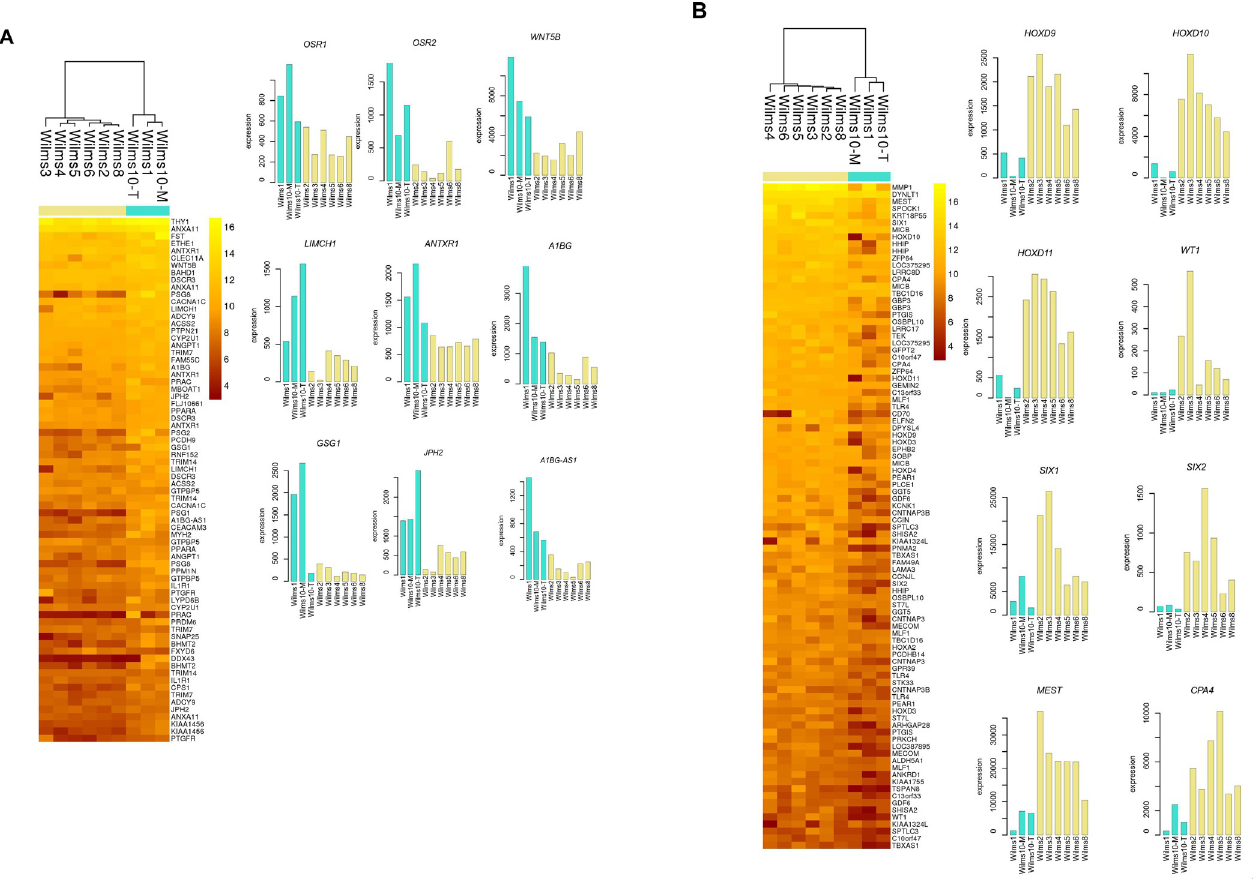
Fig 10. Differentially expressed genes in Wilms cells with and without WT1 expression. A) Heat map of the genes expressed higher in cells without WT1 : Wilms1, Wilms10T and Wilms10M (left) and expression level of selected genes with a higher expression in Wilms1, Wilms10T and Wilms10M (right). B) Heat map of genes expressed lower in cells without WT1 (left) and expression of selected genes with a lower expression in Wilms cells without WT1 expression (right).